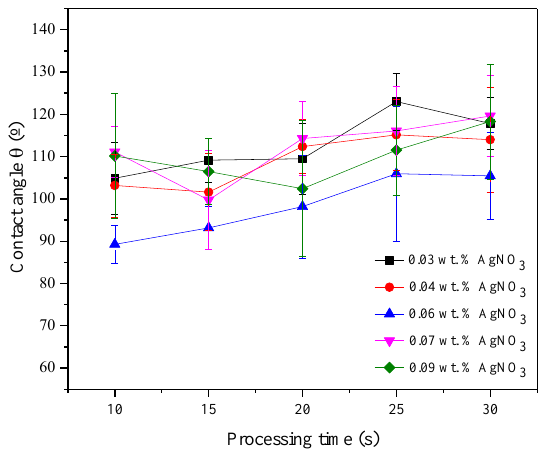
Figure 5. Comparison of the measured mean value and standard deviation of contact angles for different AgNO 3 concentrations and processing times, when KNO 3 concentration of 5 wt.% and an electrode distance of 20 mm are fixed.